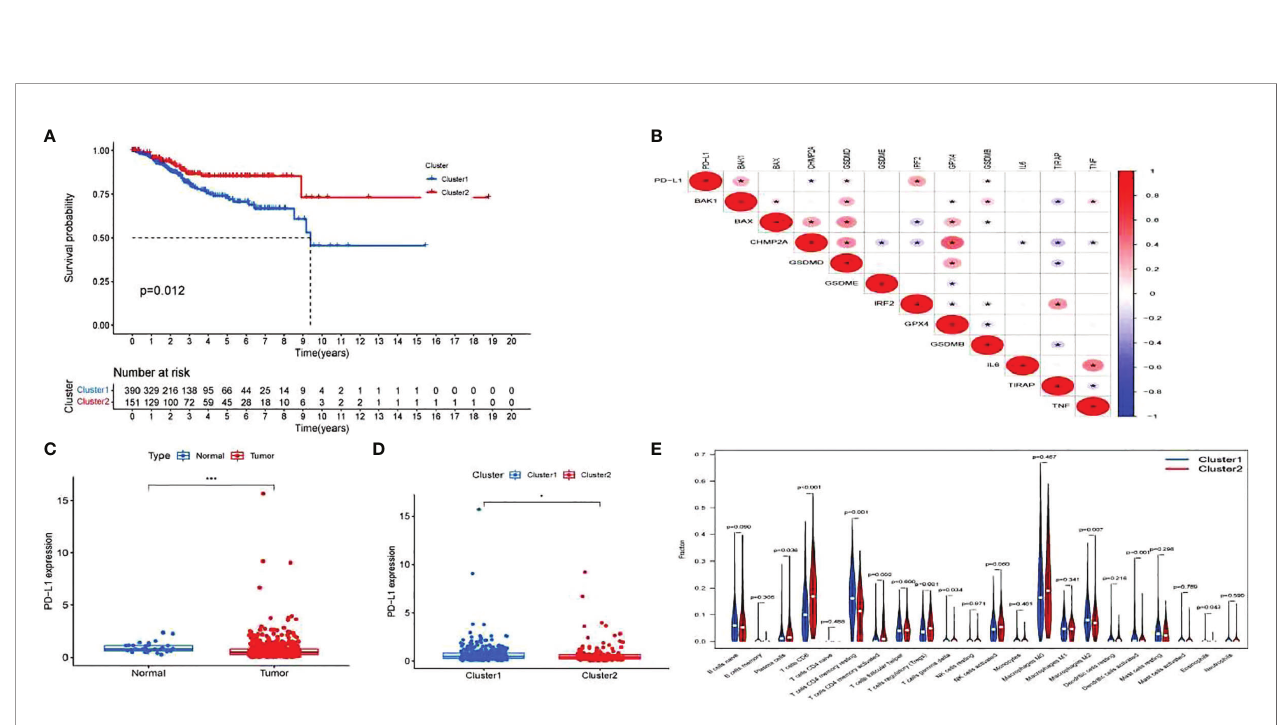
FIGURE 7 | Exploration of the clinicopathological features and immunotherapeutic response on two clusters and correlation analysis. (A) Kaplan – Meier curve of overall survival (OS) difference between Clusters 1 and 2. (B) Correlation analysis of 12 pyroptosis-related gene and programmed cell death-ligand 1 (PD-L1). P- values are shown as: *p < 0.05. (C) PD-L1 expression between uterine corpus endometrial carcinoma (UCEC) patients and normal controls. P-values are shown as: *p < 0.05; ***p < 0.001. (D) PD-L1 expression between two clusters. (E) The fraction of 22 types of immune cells in Clusters 1 and 2.